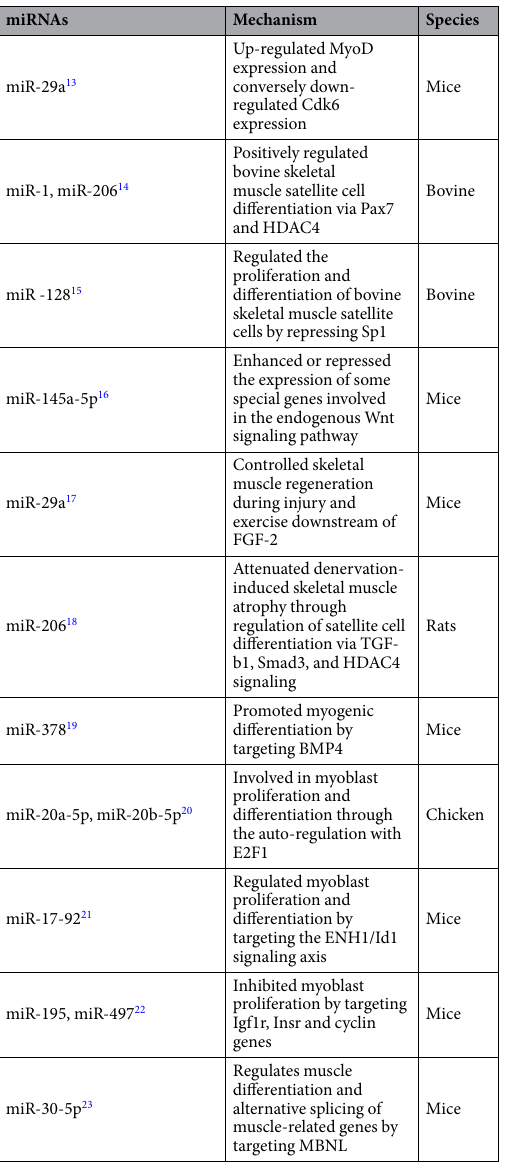
Table 1. Specific miRNAs with key roles in